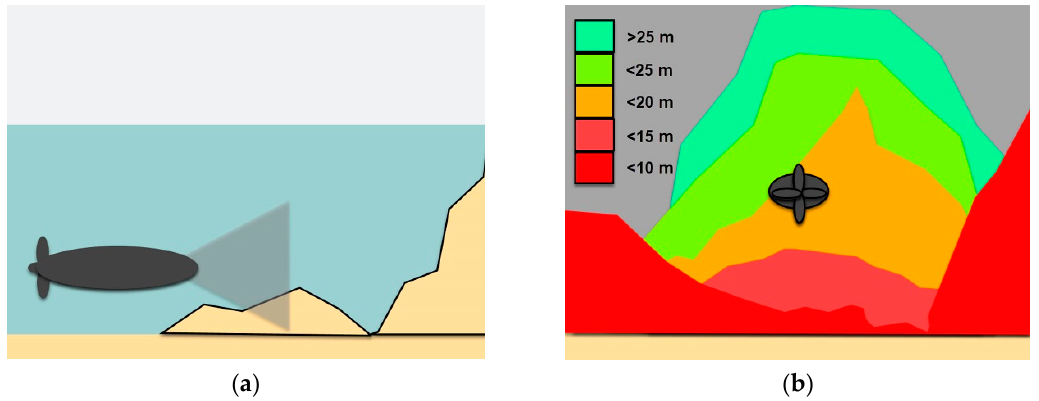
Figure 12. Simultaneous Location and Mapping (SLAM) of ( a ) an AUV equipped with a sensor to map its environment and ( b ) digital reconstruction of the environment.